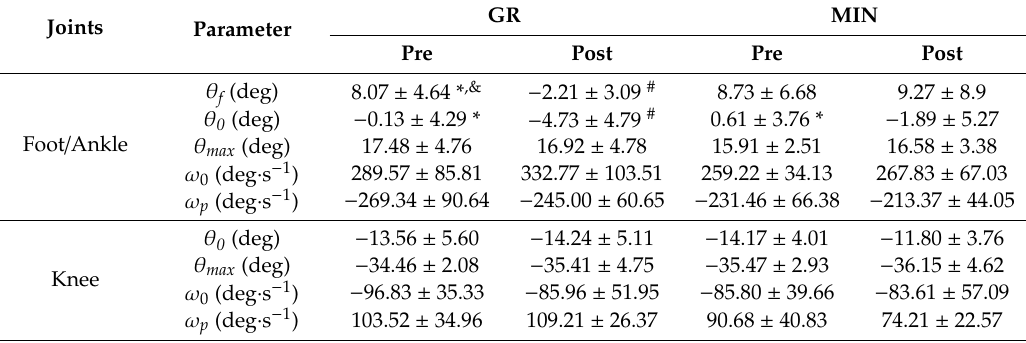
Figure 5. Comparison of foot-strike angle (left) and ankle angle (right) between two groups before and after training. * significant di ff erence from pre- to post-tests in GR group; # : significant di ff erence between groups at time point, p < 0.005; &: significant di ff erence from pre- to post-tests in MIN group. Table 4. Kinematics changes of hip, knee, and ankle before and after